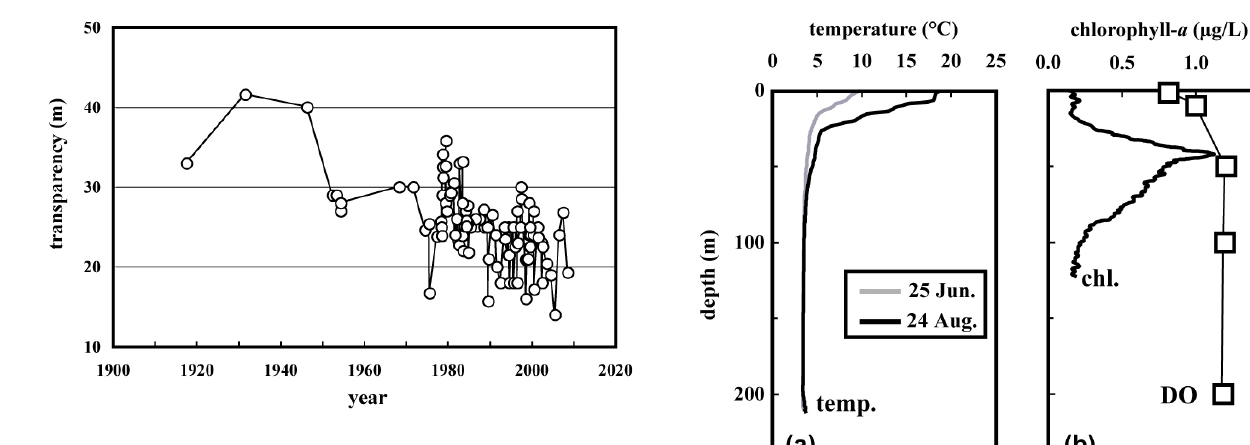
Fig. 2. The trend for transparency (Secchi depth; in meter) mea- sured at the central station of Lake Mashu. Data prior to 2003 are cited from the compiled data set in CGER NIES et al. (2004). Re- cent data were provided by the UNEP GEMS/Water Programme.